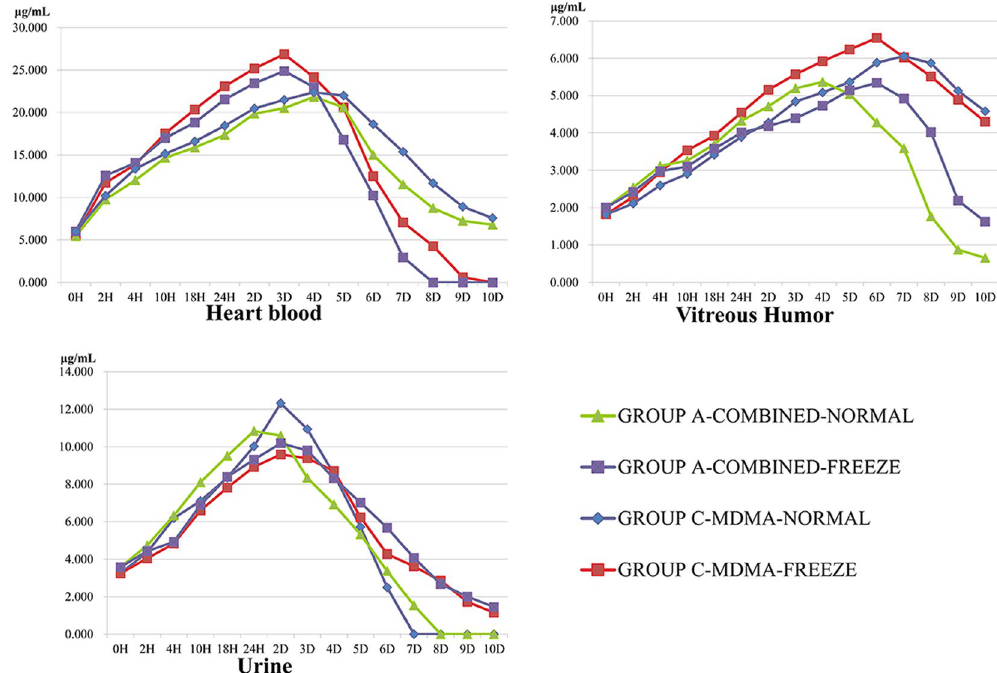
Figure 3. MDMA concentrations in body fluids in 10